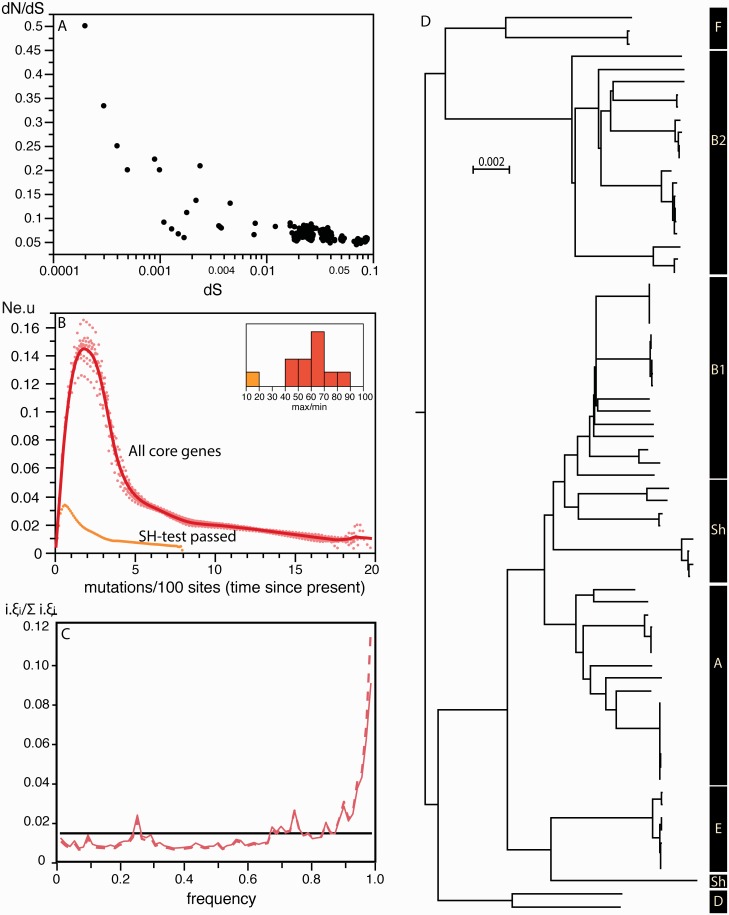
Analysis of the core genome of E. coli. (A) Values of dN/dS versus dS. Each point represents a comparison between two strains using the concatenate of alignments of genes of the core genome. (B) Skyline plot. We made ten analyses of the dataset by randomly sampling each time a tenth of the core genome. The orange line represents the skyline of the concatenate of genes with reconstructed genealogies not significantly different from those of the core genome (passed the SH test at P < 0.01). The inset represents the ratio between the maximum and minimum values of Ne.u for the 11 skyline plots (10 with the 1/10th samples of the core genome and one with the analysis of the concatenate of genes passing the SH-test). (C) The observed SFS is indicated in dashed red line, the corrected SFS (with Kimura’s two-parameter model) is indicated in solid red line. The horizontal black line indicates the neutral expectation. The corrected SFS with the JC69 model (not shown here) is similar to the SFS corrected with Kimura’s two-parameter model except for the last point, which is slightly higher. (D) E. coli distance-based phenetic tree with the major clades indicated on the right. A similar tree indicating all strains used in the analysis is in supplementary figure S6, Supplementary Material online.